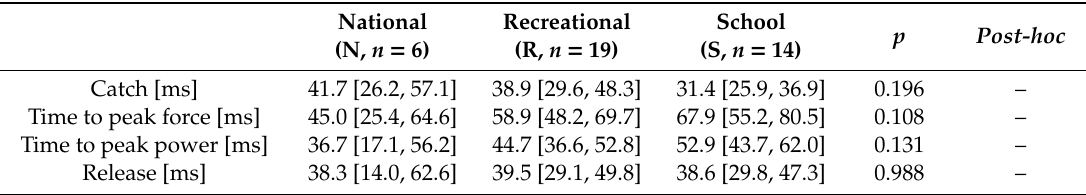
National Recreational School p Post-hoc (N, n = 6) (R, n = 19) (S, n = 14)